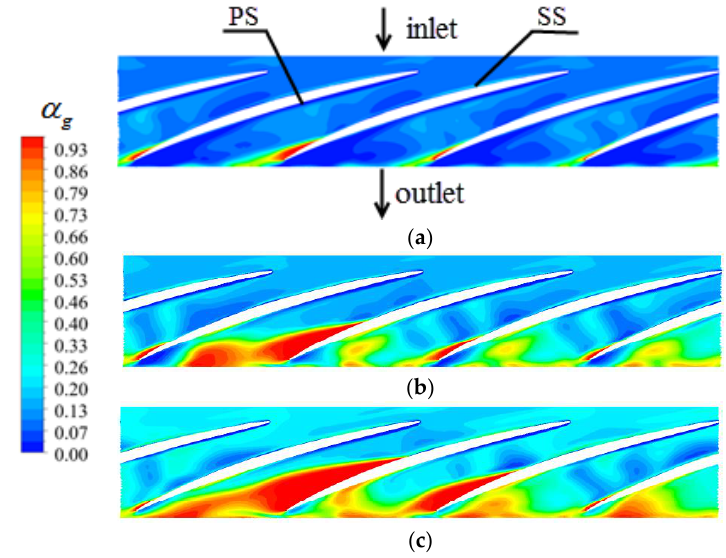
Figure 11. Gas distribution near the impeller hub at different IGVF s (span=0.1). ( a ) IGVF = 9%; ( b ) IGVF = 15%; ( c ) IGVF = 21%. PS: pressure surface; SS: suction surface.